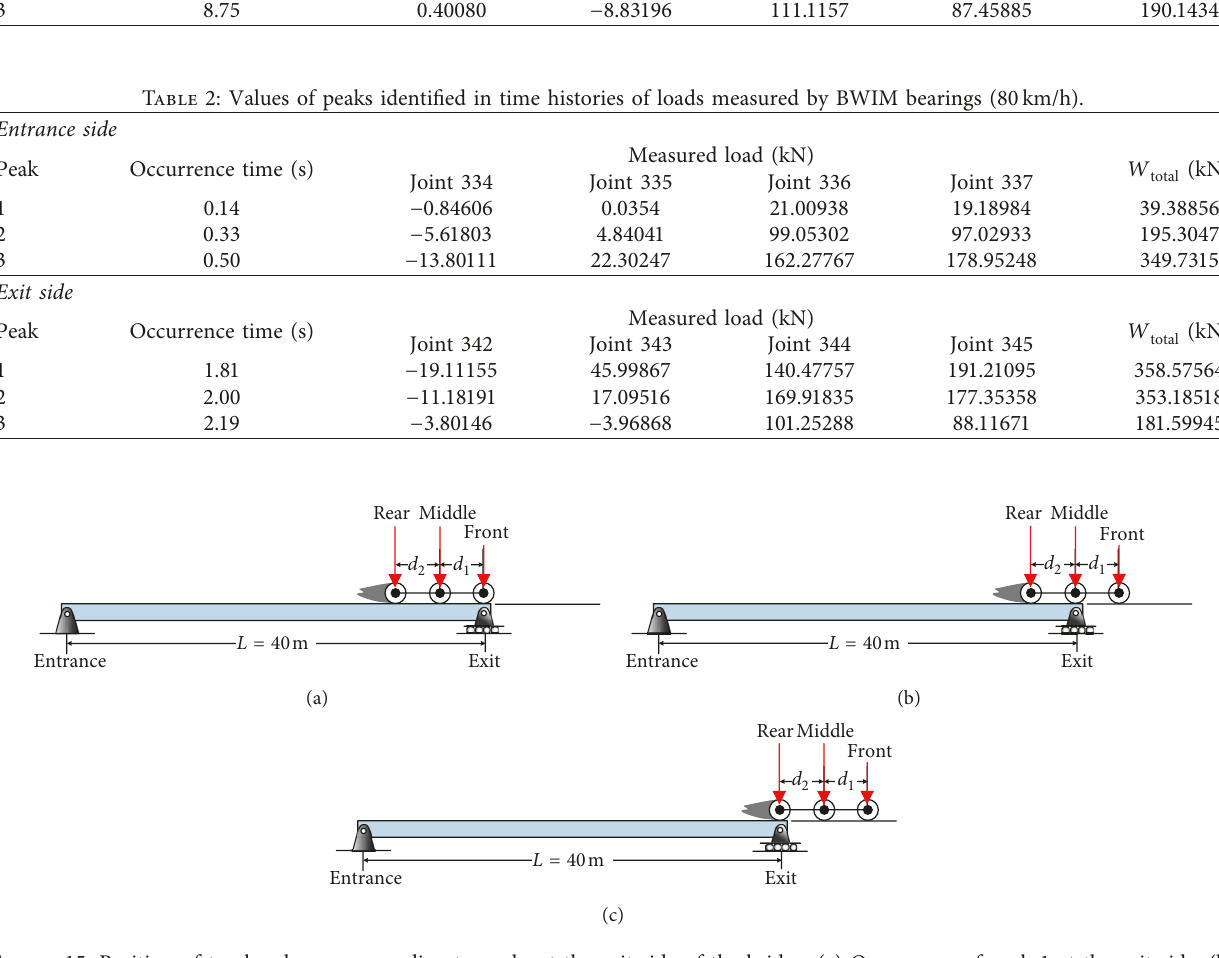
Figure 15: Position of truck axles corresponding to peaks at the exit side of the bridge. (a) Occurrence of peak 1 at the exit side. (b) Occurrence of peak 2 at the exit side. (c) Occurrence of peak 3 at the exit